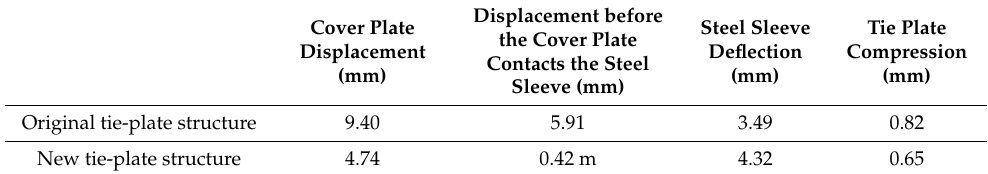
Table 1. Comparison of displacements of the original and new tie-plate structures under the rated